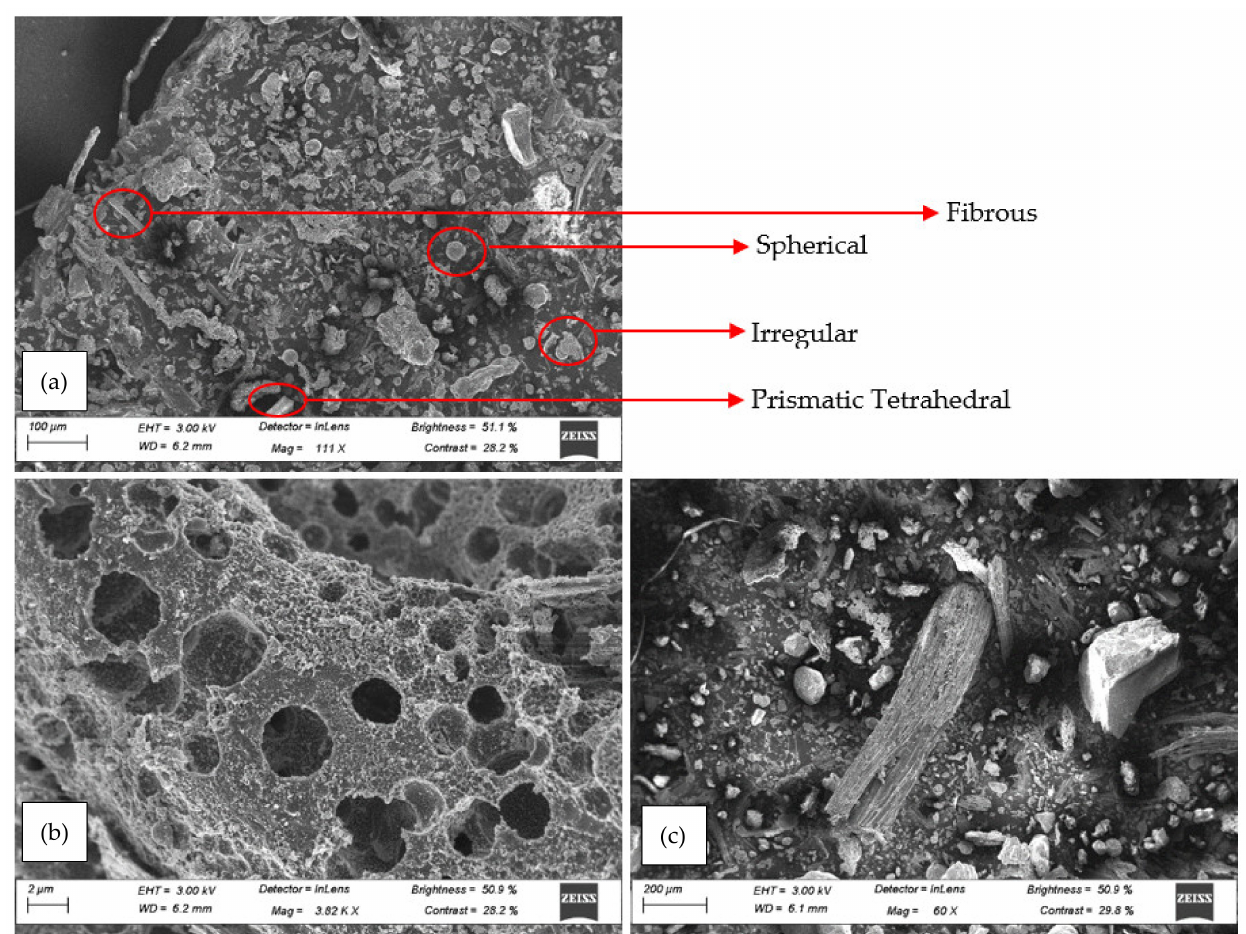
Figure 4. SEM images of processed SCBA: ( a ) prismatic tetrahedral spherical, fibrous, and irregular- shaped particles, ( b ) surface pores, ( c ) elongated-shaped particle with fibrous structure.